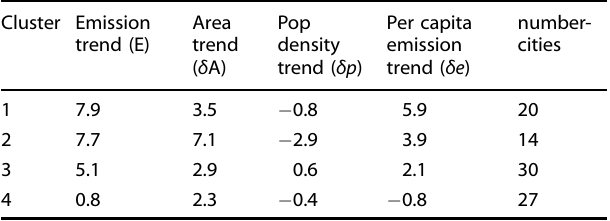
Table 3. Characteristics of clusters de fi ned as the coordinates of their centroids and the number of cities in the